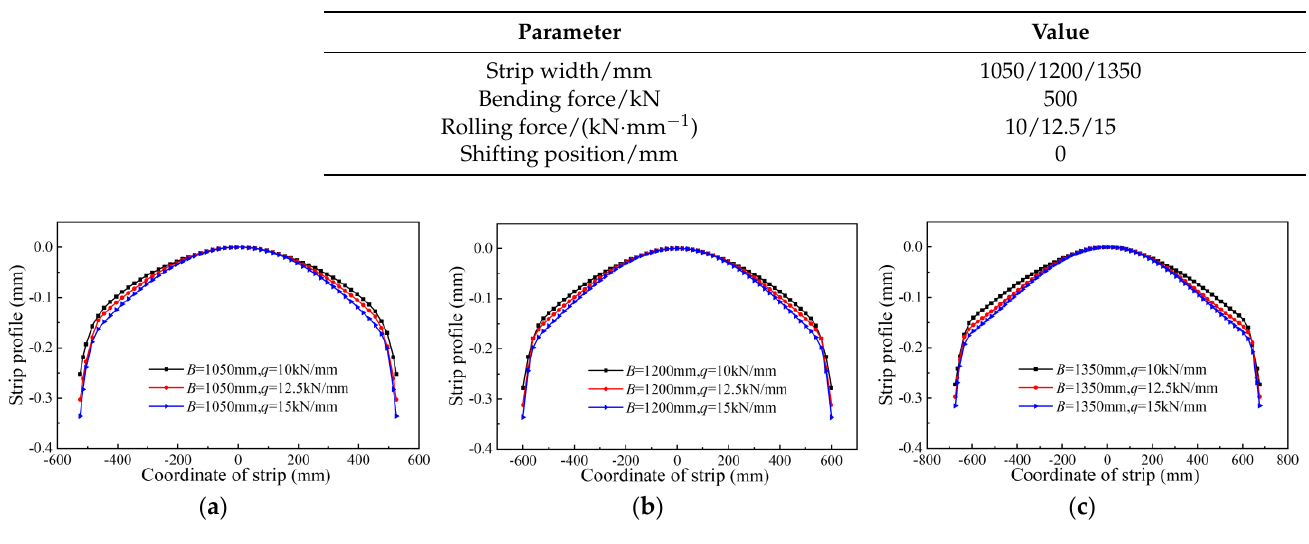
Table 8. Simulation condition of the influence of rolling force on strip crown.